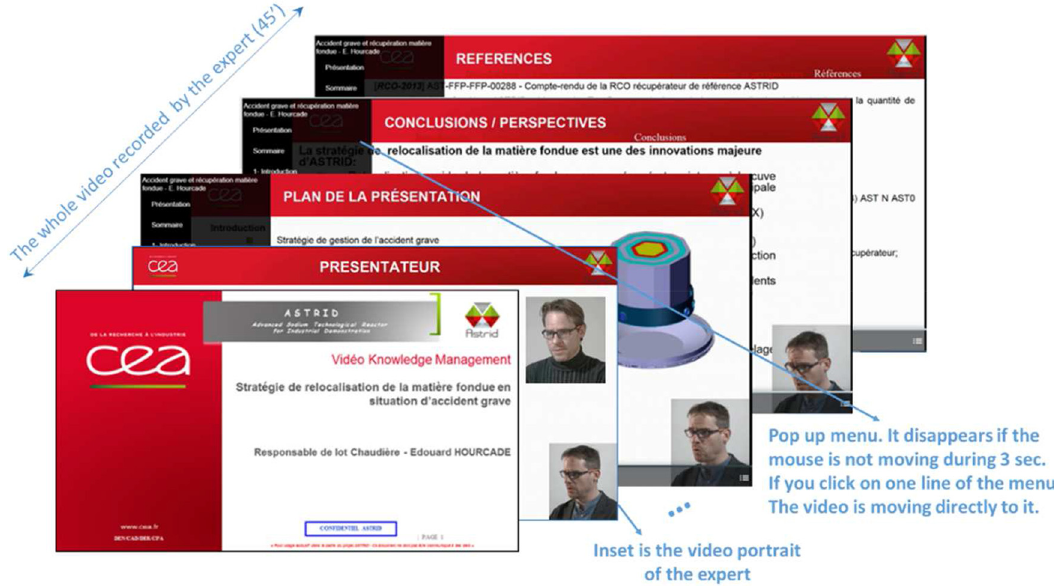
Fig. 5. Step 4 of a MOOK creation: Video post-treatment with CAMTASIA ® (Cleaning/Chaptering/Inset).